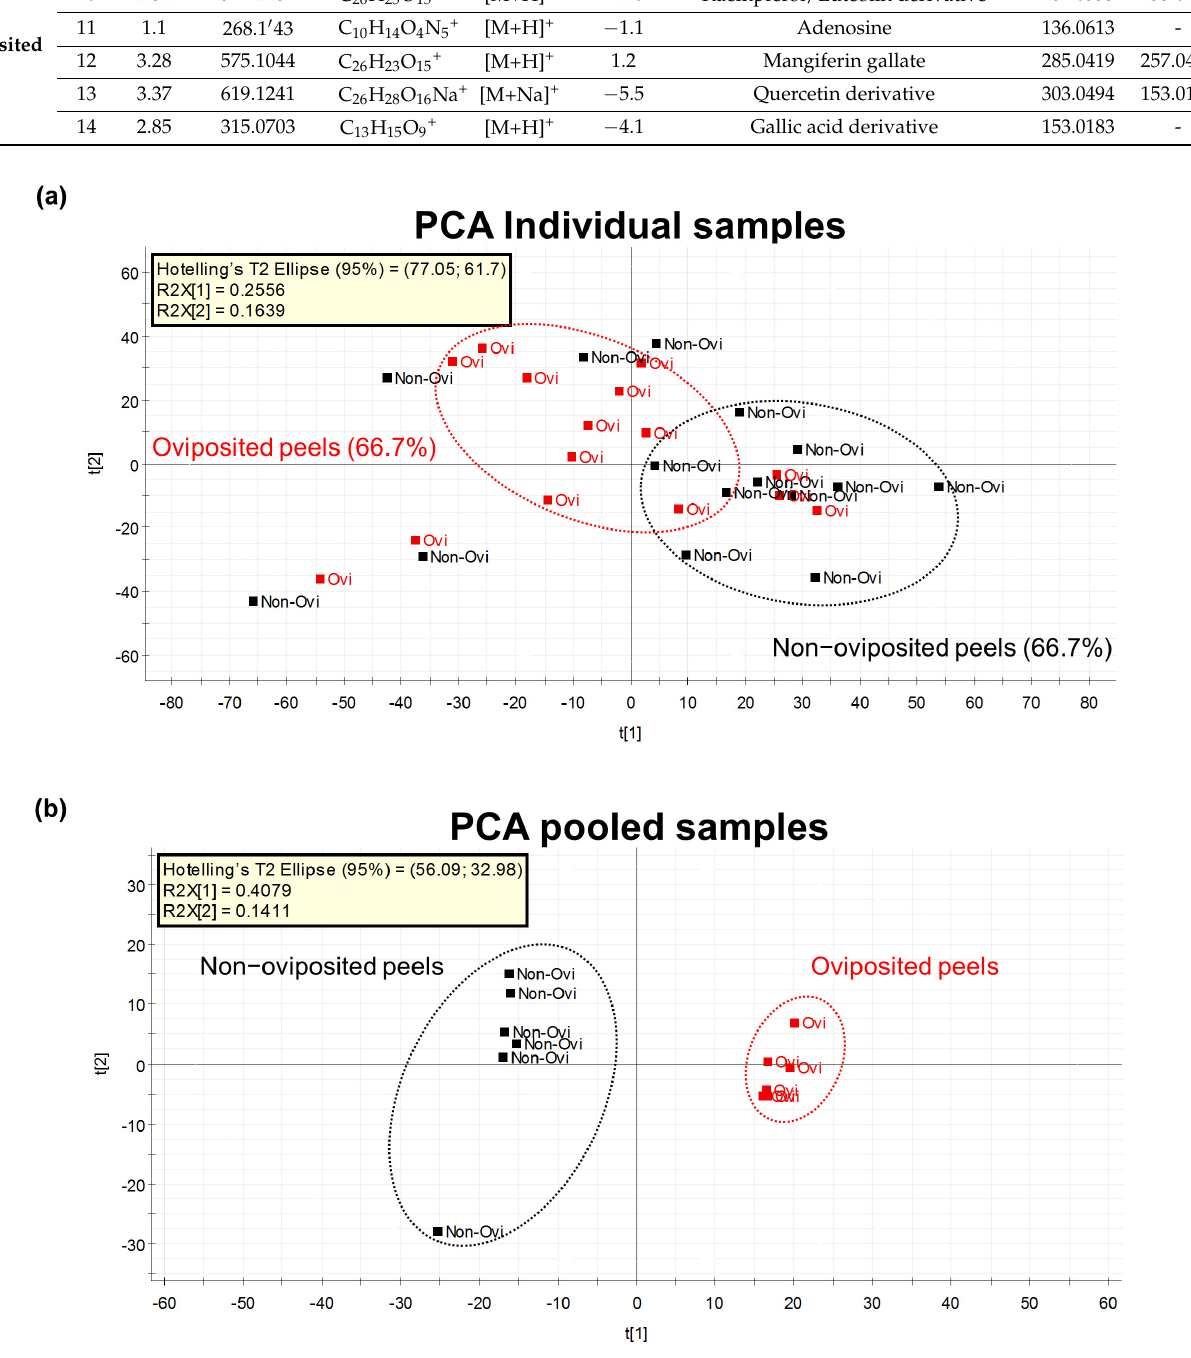
Figure 4. ( a ) PCA considering the metabolomic profiles detected by the untargeted metabolomics approach in individually analyzed “Criollo” mango peels into which A. obliqua females had inserted eggs (oviposited) or that were free of eggs (non-oviposited) ( n = 15 per treatment); ( b ) PCA on the metabolomic profiles detected in pools of “Criollo” mango peels into which A. obliqua females had laid eggs (oviposited) or that were free of eggs (non-oviposited) ( n = 6 per